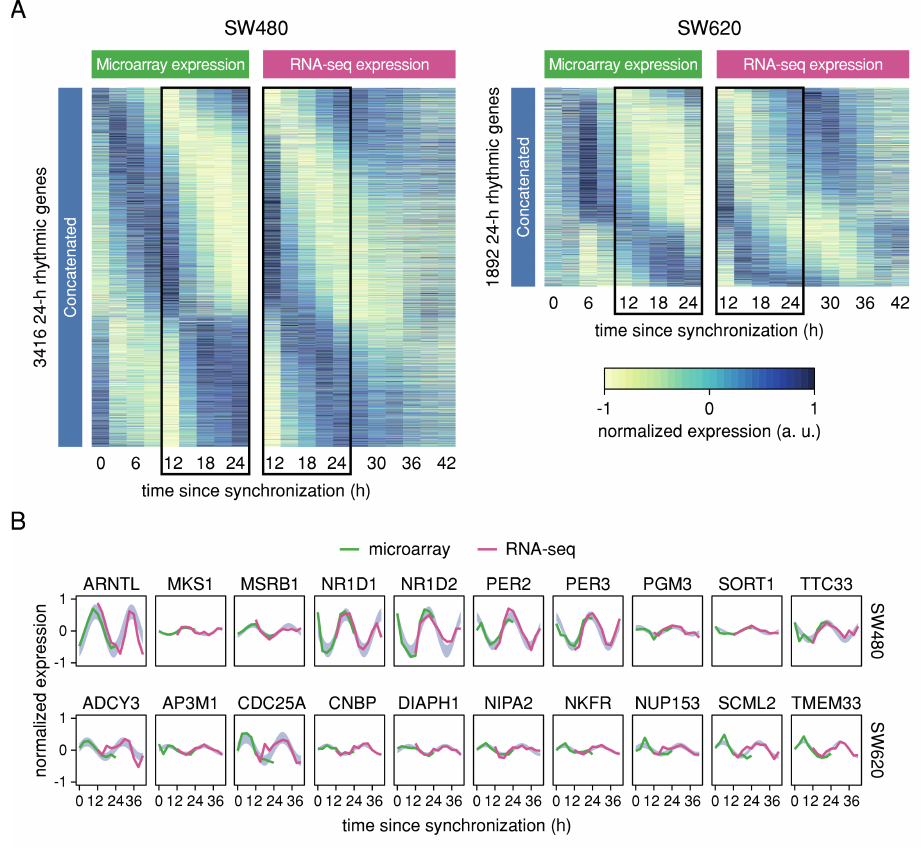
Figure 3. Concatenation of samples from circadian microarray and RNA-seq datasets reveals robustly 24-h rhythmic genes across platforms. ( A ) Range-normalized, phase-ordered microarray (respective left panel) and RNA-seq expression (respective right panel) heatmaps of genes that were identified as 24-h rhythmic in SW480 cells (two leftmost panels) and SW620 cells (two rightmost panels) in the concatenated data. Each row represents one gene. Phases were estimated based on the concatenated data. Black rectangles mark the shared time points between the microarray and the RNA-seq data. ( B ) Normalized time-series expression of the top ten 24 h rhythmic genes identified in SW480 cells (top row) and SW620 cells (bottom row) based on the concatenated data. Microarray expression values are represented by green lines and RNA-seq expression values by pink lines. The blue area marks the confidence area of the harmonic regression fitted to the concatenated data for 24-h rhythmic